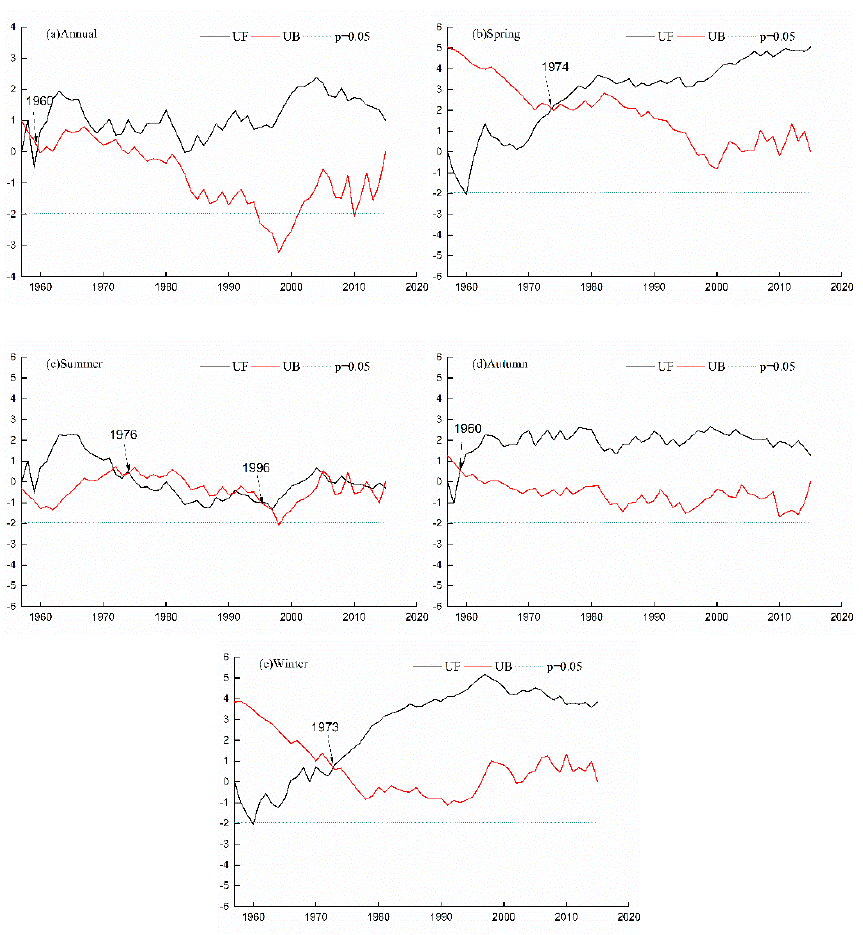
Figure 5. Abrupt change of annual and seasonal precipitation in the YLZR basin during 1957–2015. The M − K test results of the annual and seasonal average air temperature during 1957–2015 are shown in Figure 6. In comparison with the changes of precipitation, the changes of air temperature are relatively simple. Unlike the annual average air temperature, the average air temperature in each season was within the confidence interval. Analysis based on a moving t test showed that the annual average air temperature changed abruptly in 1989. Seasonally, abrupt changes in air temperature occurred in spring in 1992, summer in 2000, autumn in 1992, and winter in 1993. In the YLZR basin, abrupt changes in annual and seasonal average air temperature occurred around the 1990s.